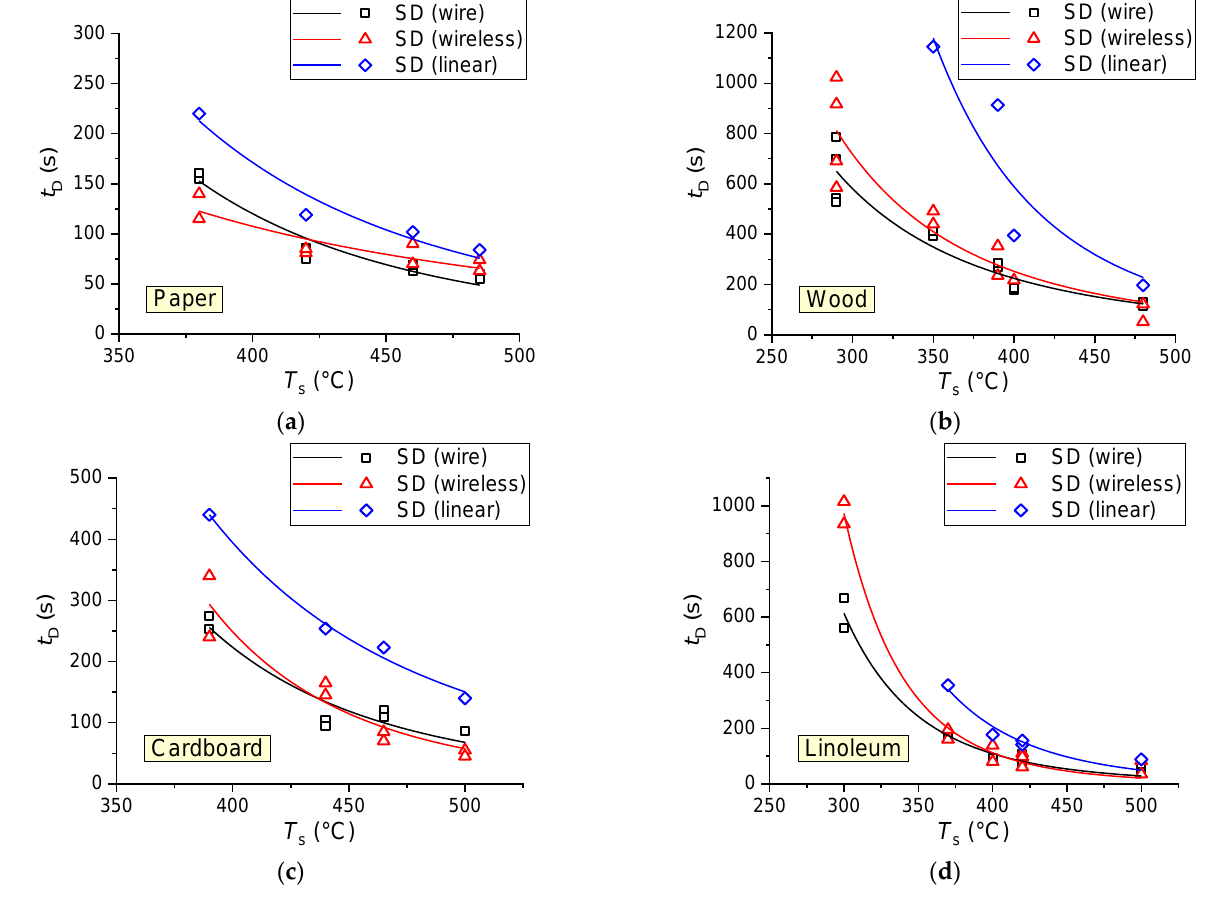
Figure 8. SD activation delay times when varying the hot plate surface temperature using model fires involving paper ( a ), wood ( b ), cardboard ( c ) and linoleum ( d ): SD (wireless) is a wireless smoke detector; SD (wire) is a smoke detector connected in the circuit; SD (linear) is a linear smoke detector.